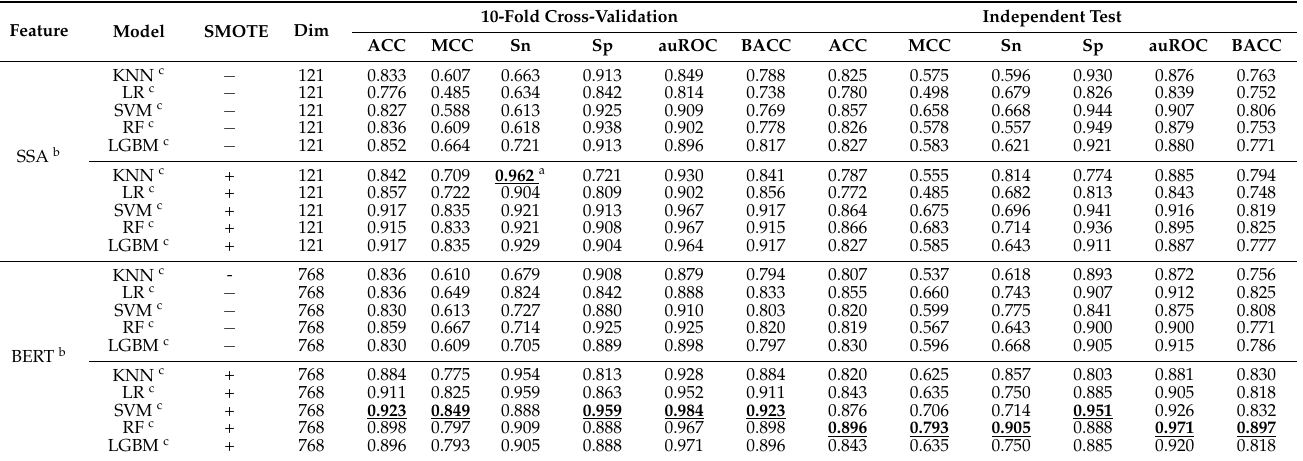
Table 1. Performance metrics of two different deep representation learning features using five machine learning models with or without